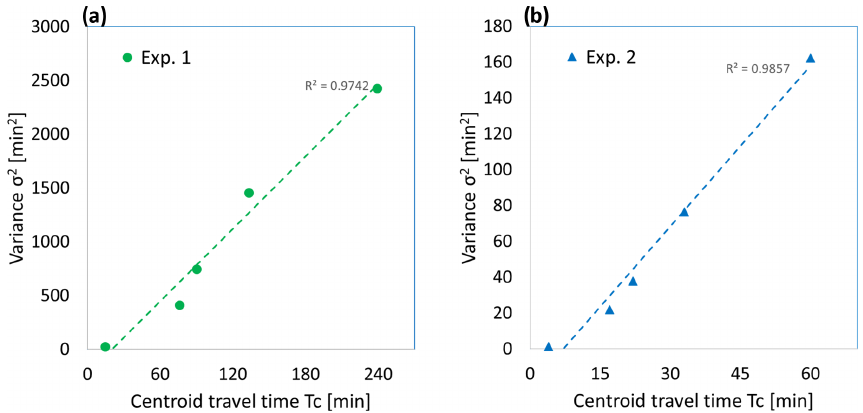
Figure 9. Variance ( σ 2 ) of the temporal concentration distributions against the centroid travel time ( T c ) during (a) Exp. 1 and (b) Exp.